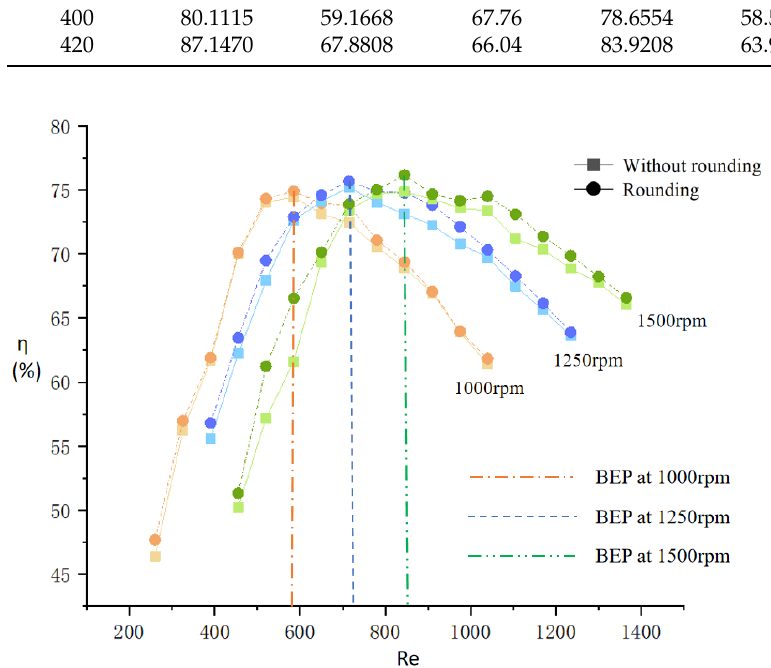
Figure 8. Reynolds number versus efficiency curves at 1000 rpm, 1250 rpm, and 1500 rpm.